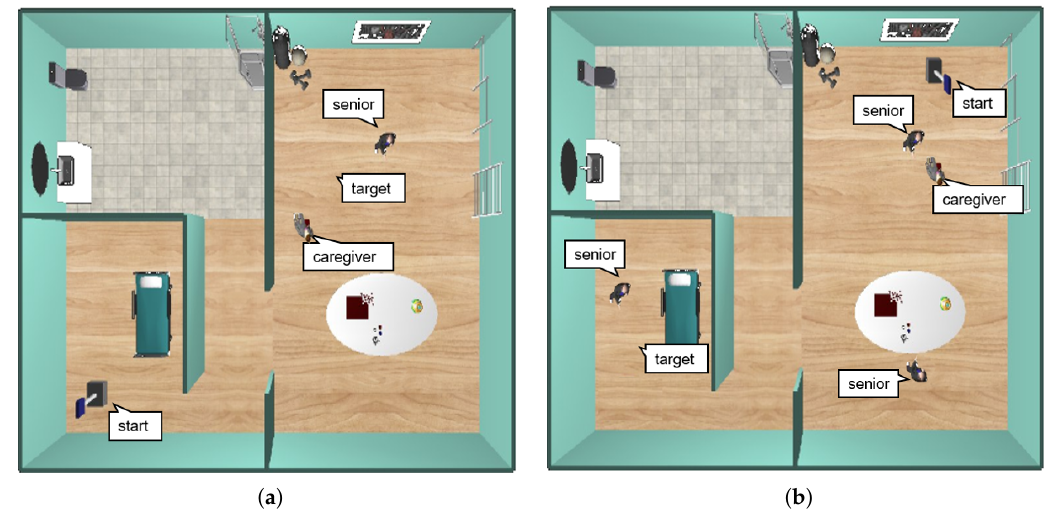
Figure 10. Two use cases are used in this paper to validate the proposed CPS-AAL: ( a ) The robot acts as an assistant that warns the users (older adults) that the therapy is over, and ( b ) the robot acts as a virtual physical therapist that navigates to the user and proposes a physical activity. A more detailed description of the use cases is in Tables 2 and 3, respectively. Table 2. Use case 1: The robot acts as an assistant that warns the user that the therapy is over. Actor Action The caregiver keeps the therapy schedule updated on the center’s Caregiver calendar